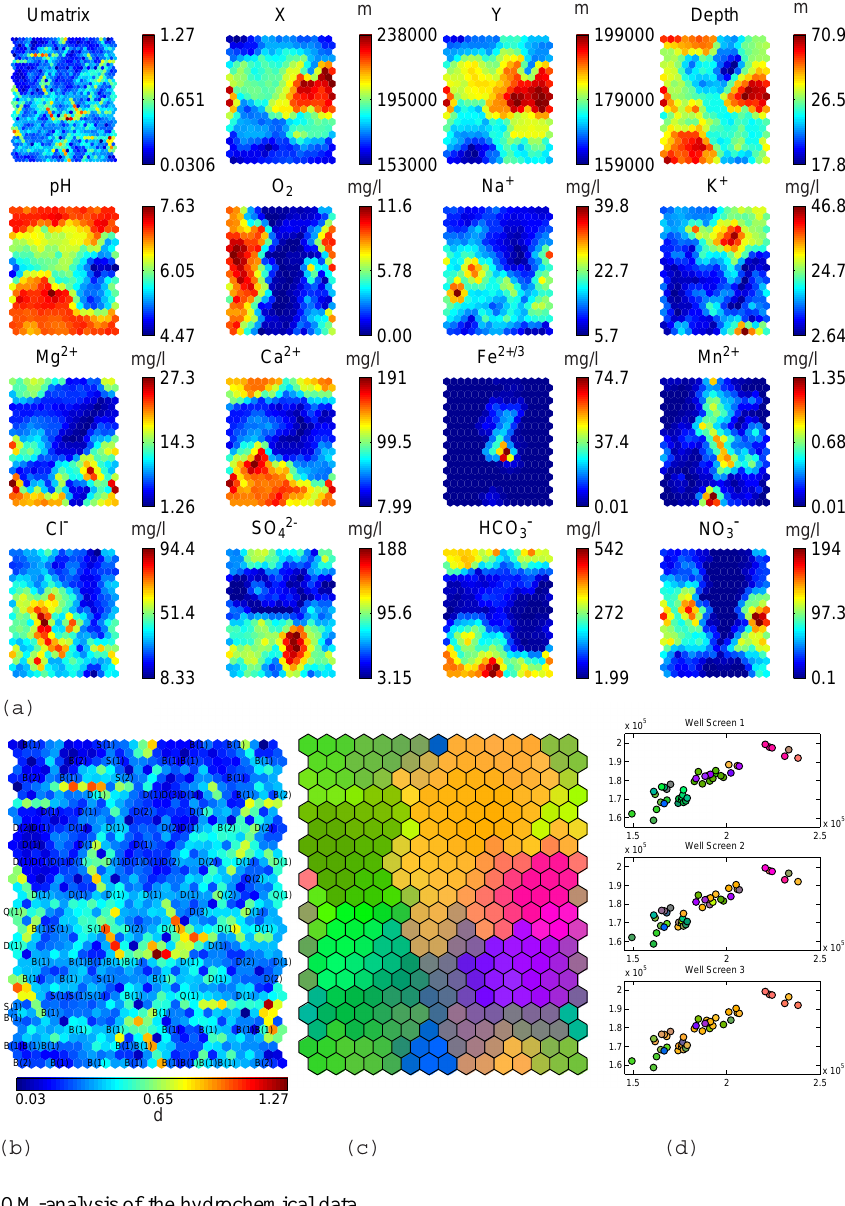
Fig. 8. Results of the SOM-analysis of the hydrochemical data